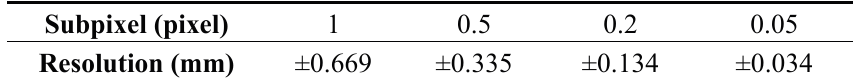
Table 2. Different levels of subpixel